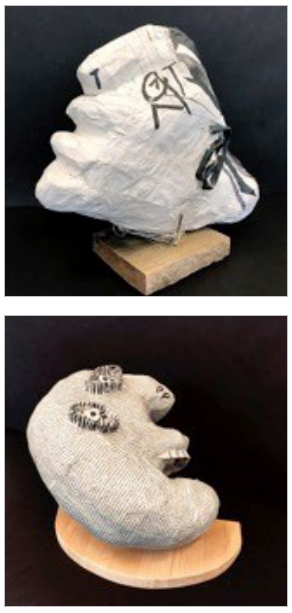
Figs. 2, 3 Students of the Visual and Plastic Art Design workshop, D’après Guernica , 2021, papier- mâché , wood,